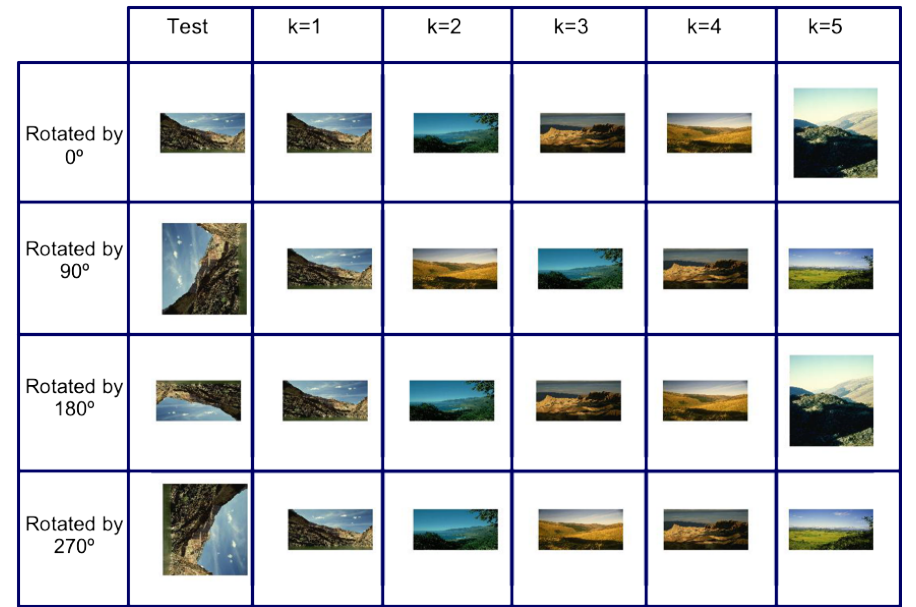
Figure 9. Images test rotated by 90, 180, and 270 degrees.